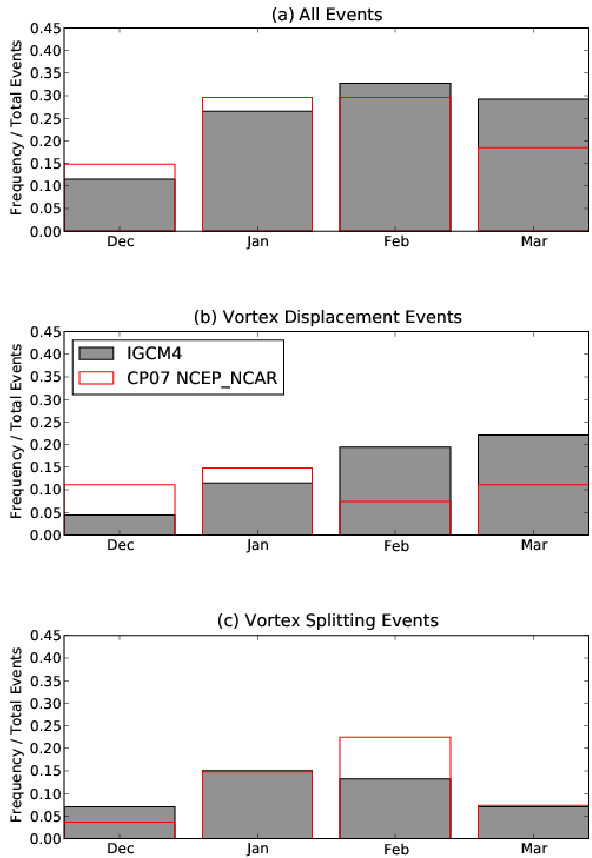
Figure 10. Distribution of sudden stratospheric warmings in bo- real winter by month in the IGCM4 (filled grey boxes) and reanal- ysis (red outline boxes; a ), distribution of displacement-type warm- ings (b) and distribution of split-type warmings (c) .